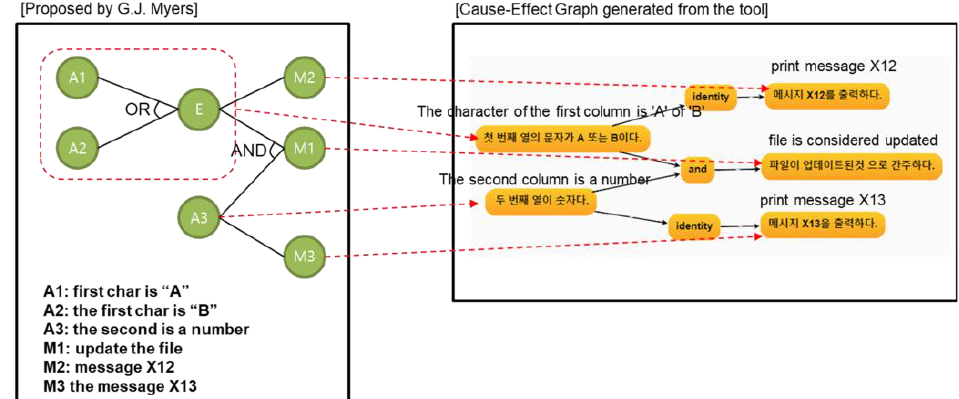
Figure 17. Comparison between Myers’s cause – effect graph and KRA- CE’s cause – effect graph [2].